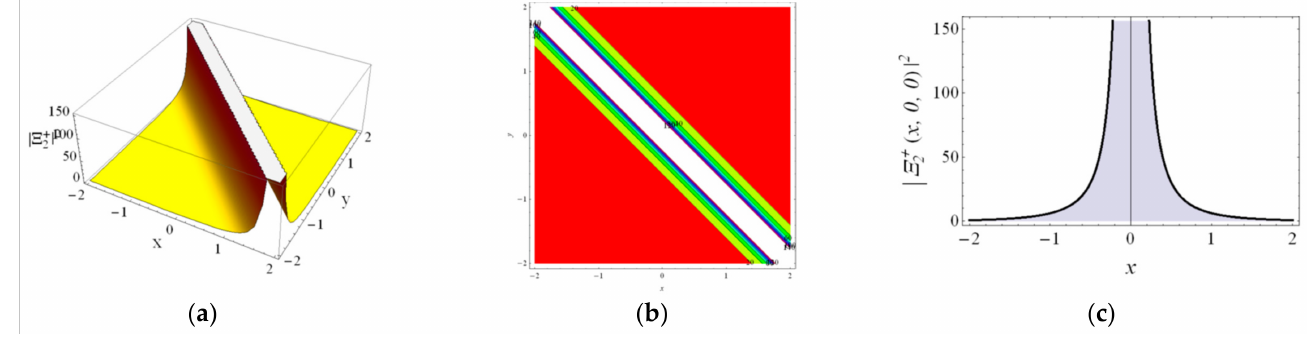
(cid:12) (cid:12) 2 with the parameters ε (cid:12) Ξ + 2 (cid:12)